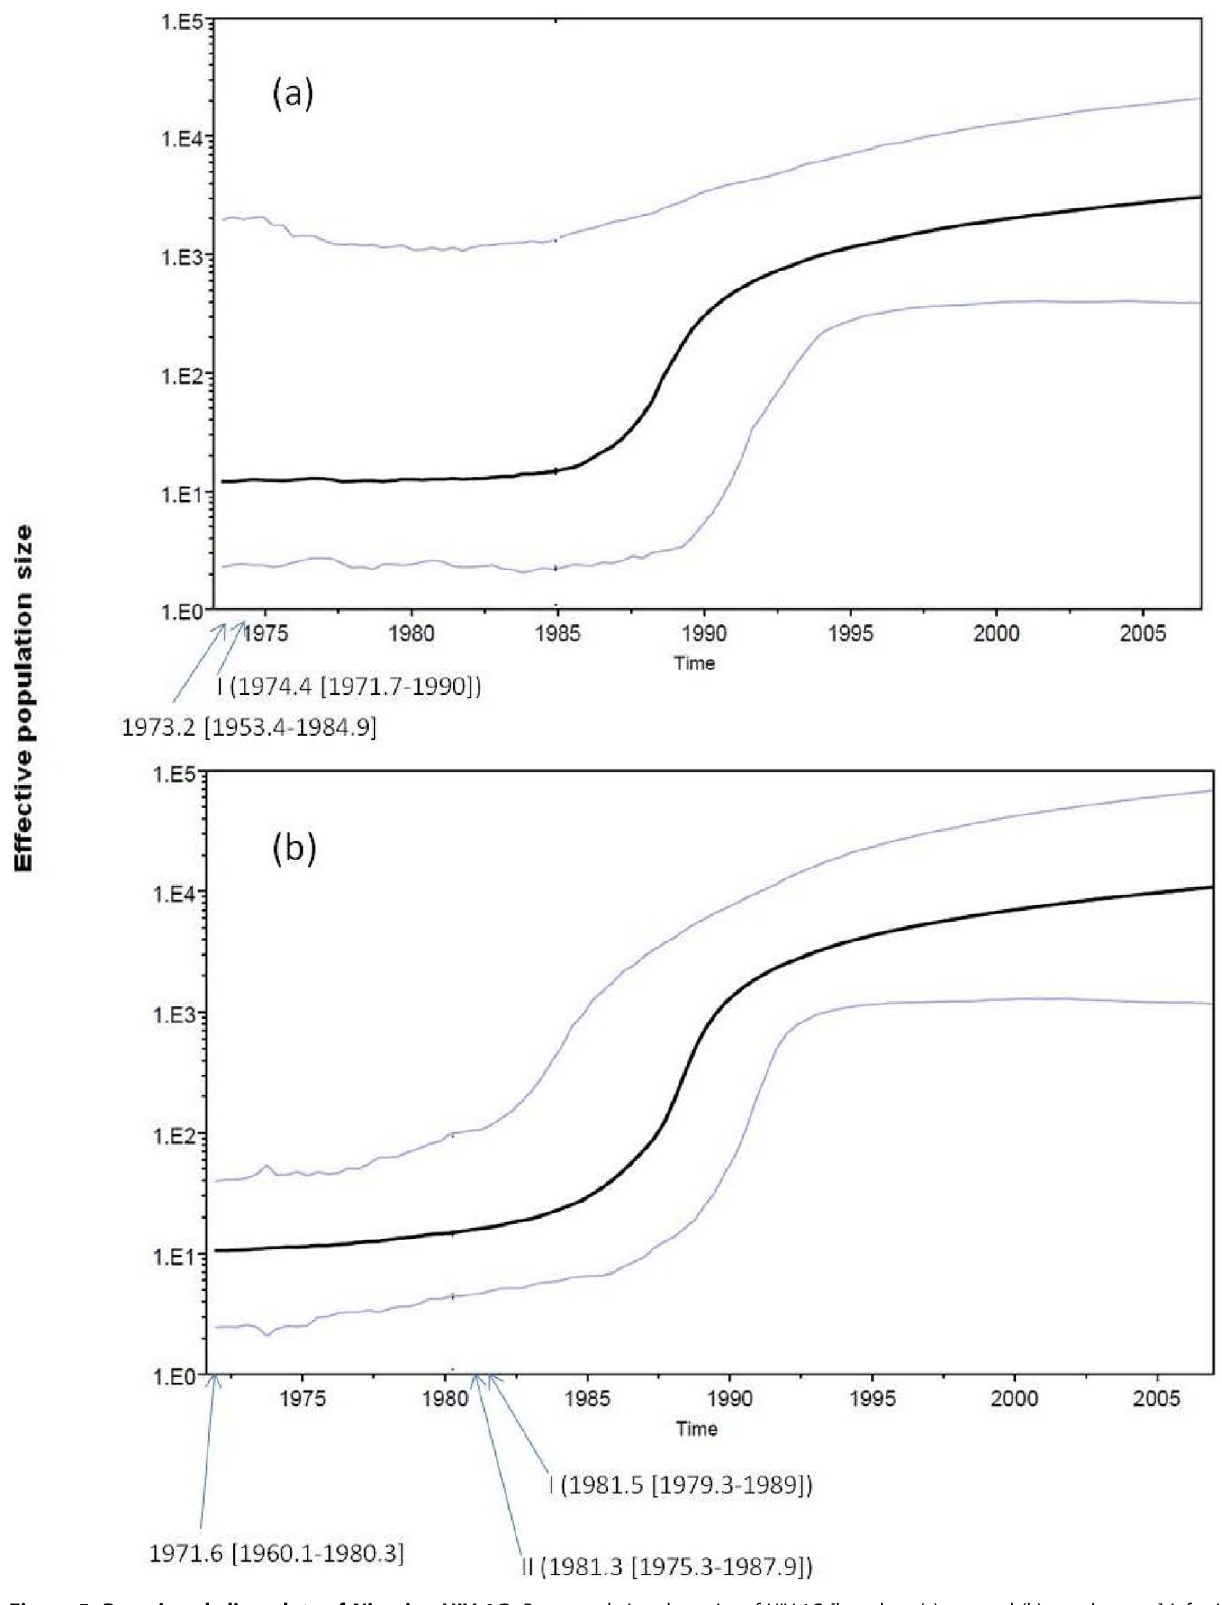
Figure 5. Bayesian skyline plots of Nigerian HIV-1G. Past population dynamics of HIV-1G [based on (a) gag and (b) env data sets] infections reconstructed by Bayesian skyline plot. The first arrow from the left indicates the time of the MRCA. The other arrows indicate the estimated origin of the correspondingNigerian clade (indicated by the Roman numeral) inthe trees in Figure 4 c andd. HPDs (95%) aregiven in parenthesis beside each estimate.